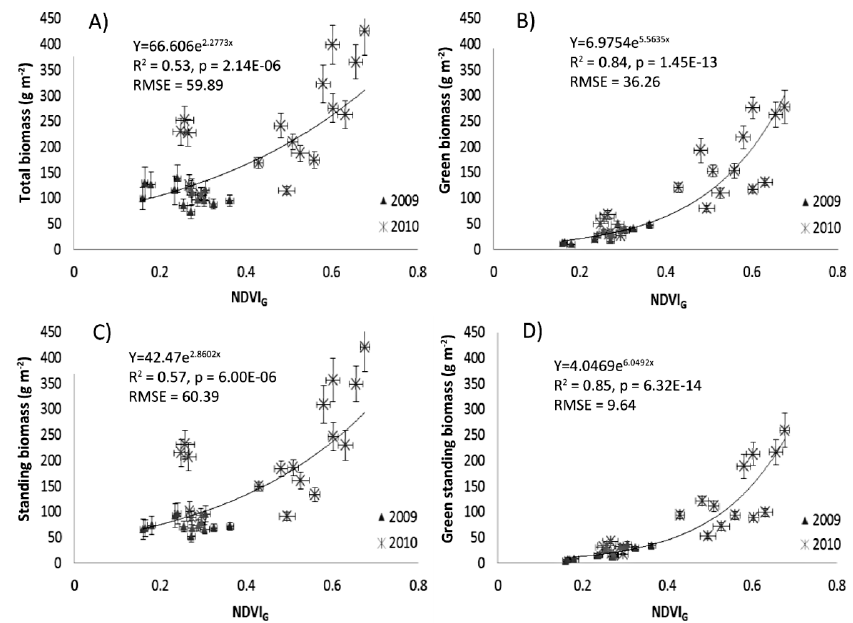
Figure 6. Relationship between NDVI and biomass for the Sounding Creek and Pinhorn grazing reserves in the 2009 and 2010 combined growing seasons. Regressions between NDVI G (X variable) and several expressions of biomass (Y variables), including Total Biomass ( A ); Green Biomass ( B ); Standing Biomass ( C ); and Standing Green Biomass ( D ). Exponential fits and regression statistics ( R 2 , p , and RMSE values) are also shown. Error bars are the standard error of the mean. See Table 1 for further explanation of biomass metrics.